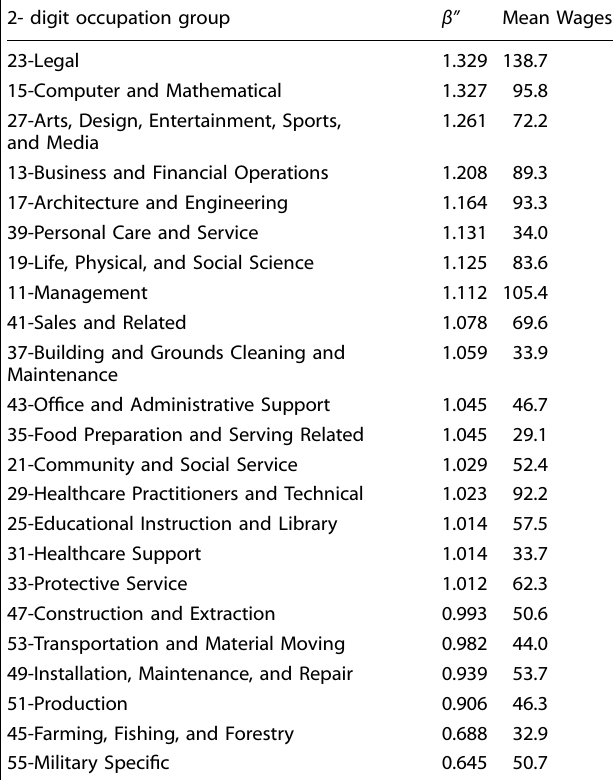
Table 2. Comparison of 2019 power-law scaling exponents for MSA 2-digit occupation employment vs. MSA size, with mean annual wages (in thousands of $).